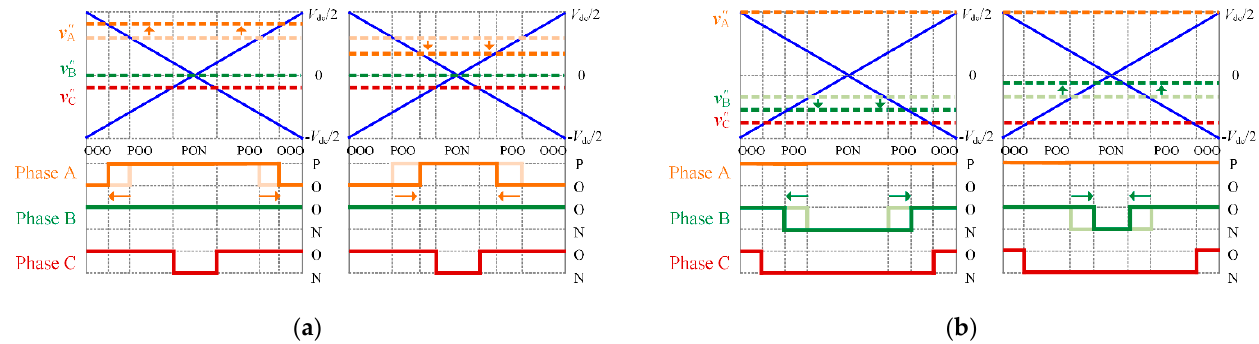
Figure 8. The influence of v os on the switching sequence. ( a ) Adjustment of V 13L in region R III ; ( b ) Adjustment of V 7 in region R I .